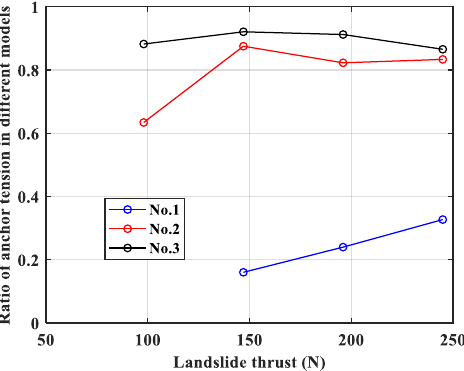
Figure 8. Ratio of anchor tension in different pile material models.